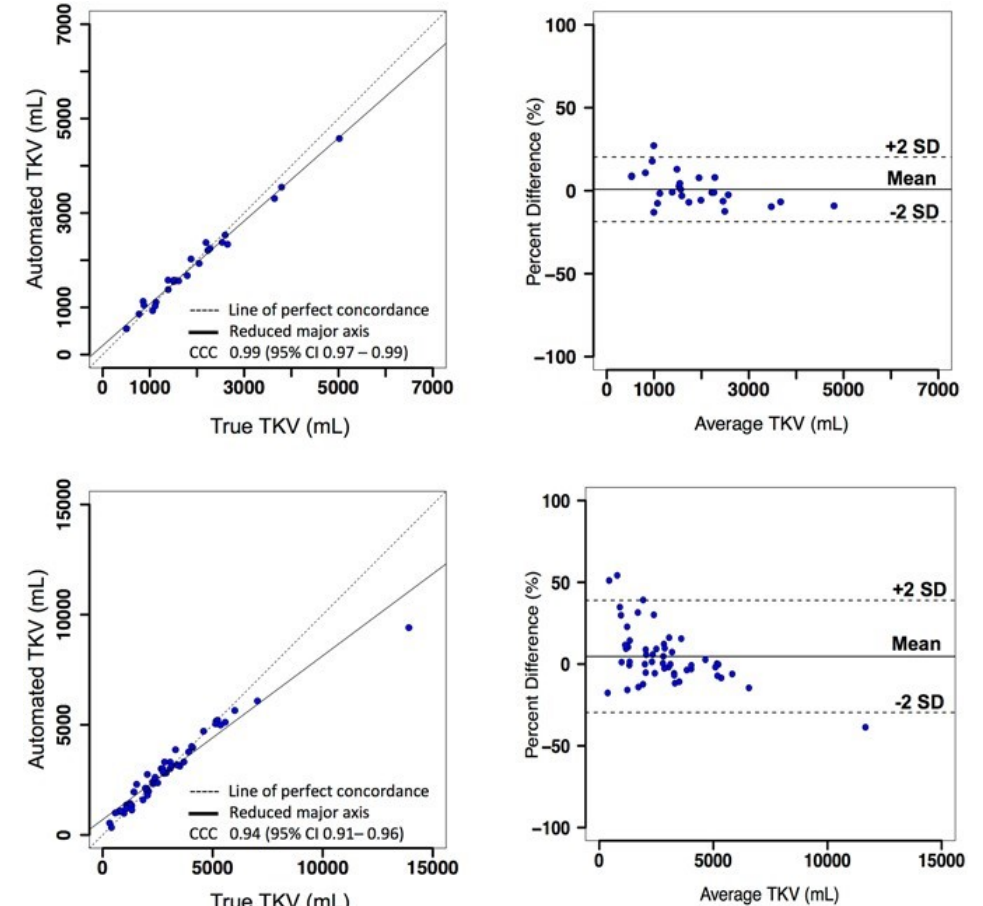
Figure 11. Concordance Correlation Coefficient (CCC) plots demonstrating affiliation intensity (left). Bland–Altman plots display TKV evaluation agreement (right). Reproduced with permission from [178].